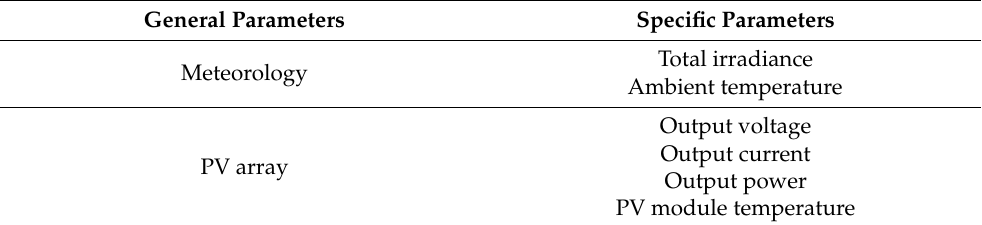
Table 4. PV System parameters to be monitored in